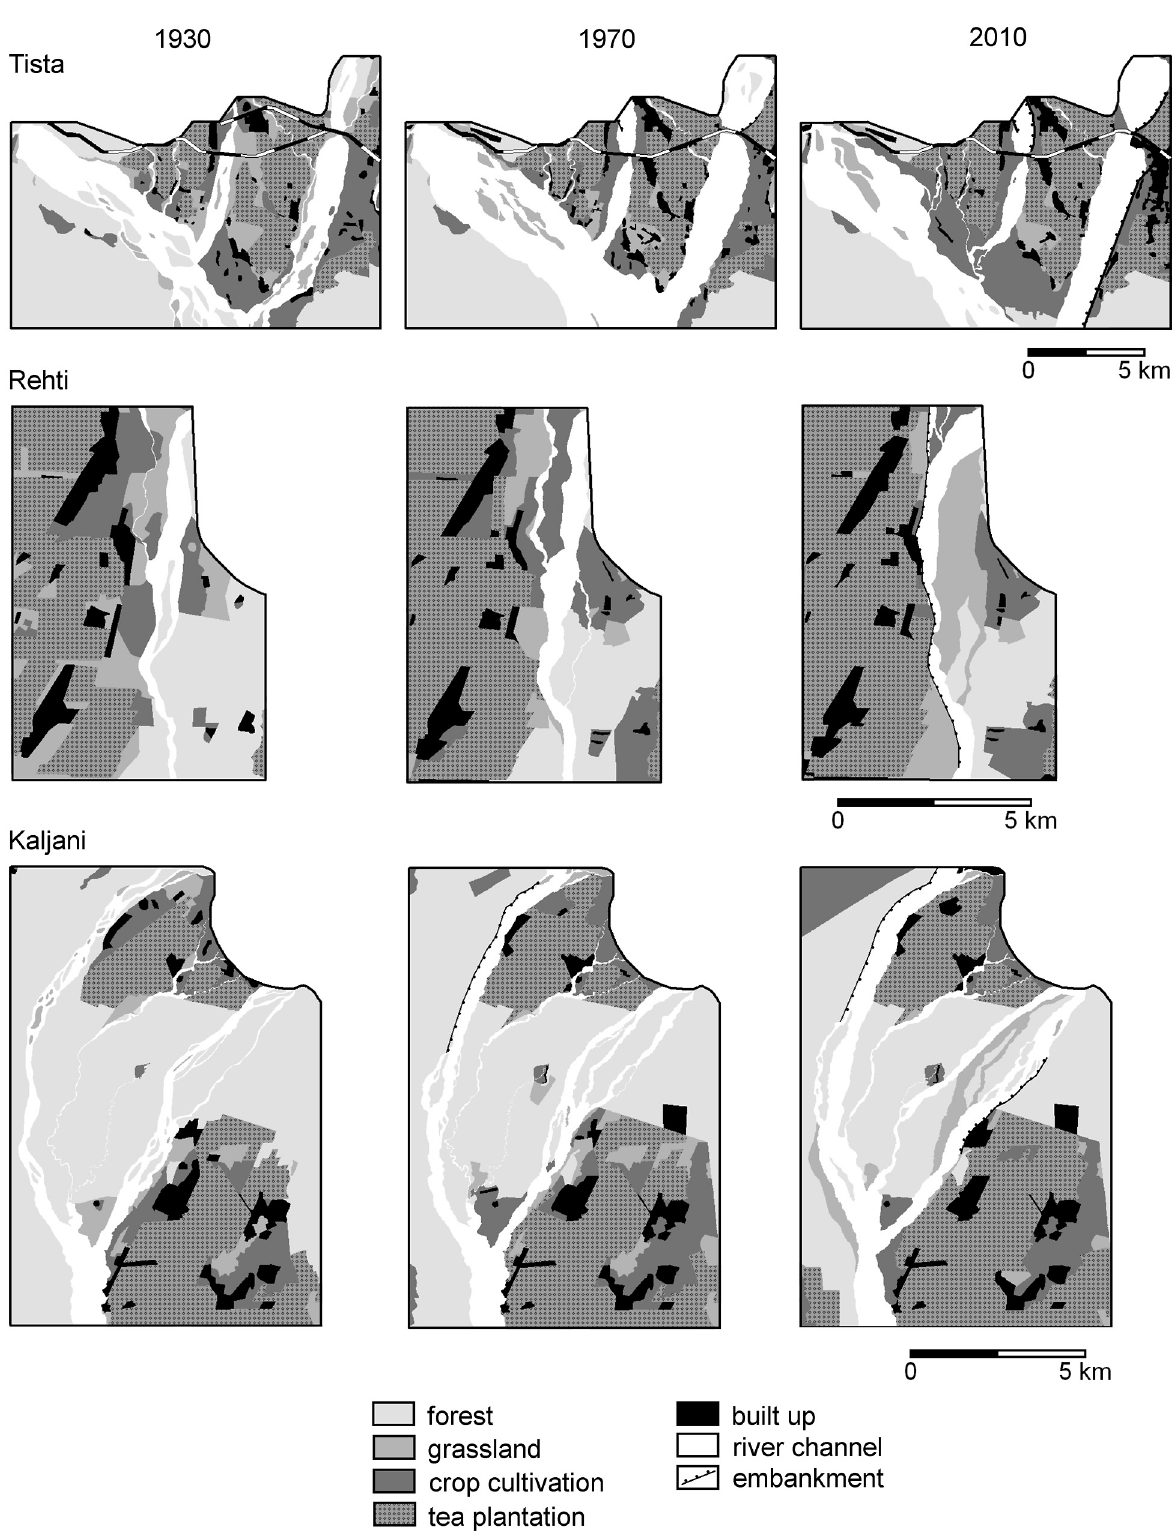
Fig. 4. Spatial distribution of LULC in the selected study